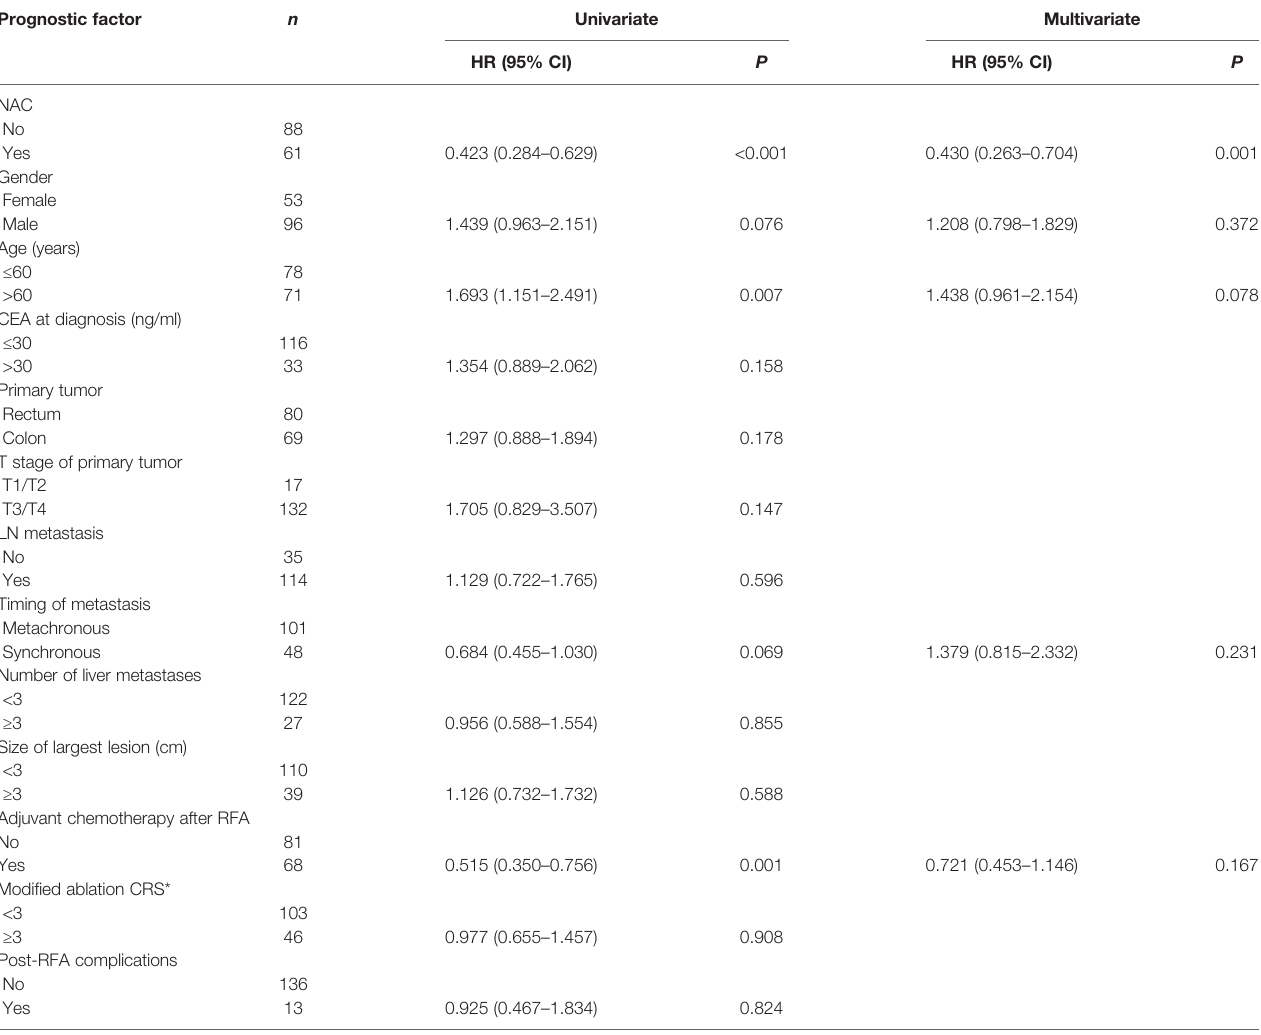
TABLE 5 | Analysis of prognostic factors associated with PFS. Prognostic